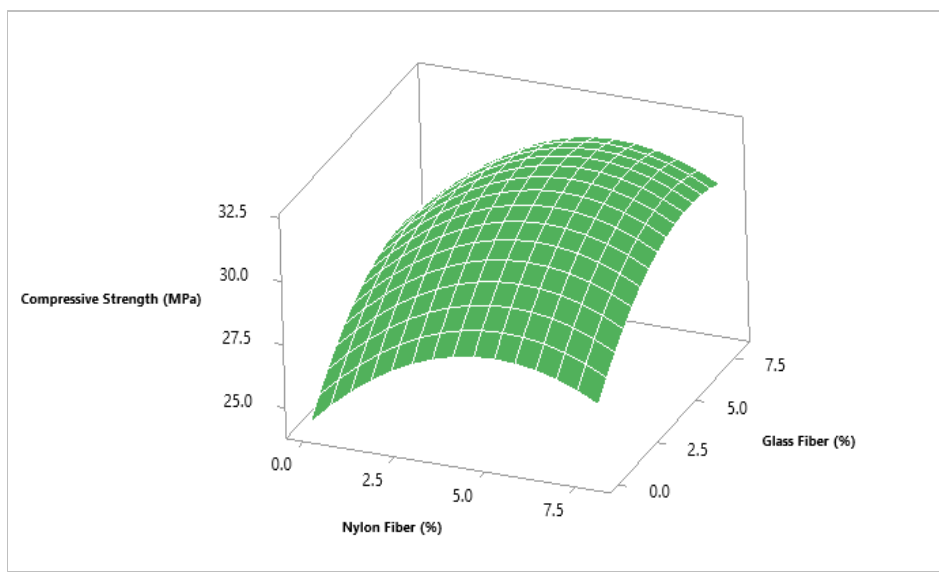
Figure 6. Three-dimensional response surface for compressive strength (MPa).